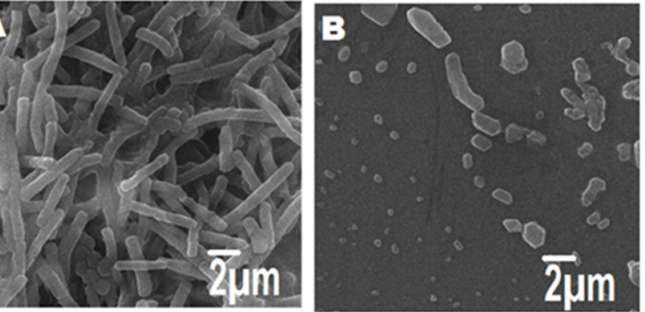
Figure 9. Morphological features of MDR E. coli -induced mastitis treated (or not) with CIP- Ag/TiO 2 /Fe 2 O 3 /CS nanoformulation (NDDS) at MIC; ( A ) untreated MDR E. coli cells (negative control); ( B ) treated MDR E. coli cells. Scale bar is mentioned.